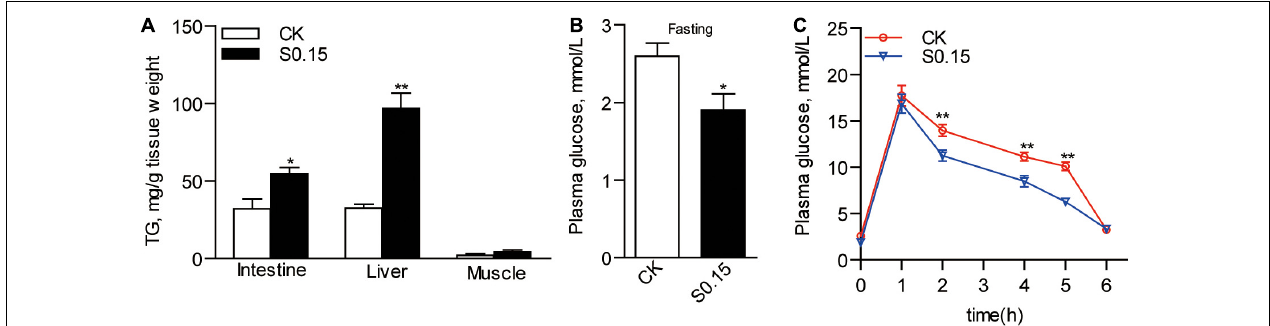
FIGURE 5 | Fat accumulation and glucose homeostasis in zebrafish fed the CK or S0.15 diet for 4 weeks. (A) Intestinal, hepatic, and muscular TG levels. (B) Fasting plasma glucose levels. (C) Glucose tolerance test. Values are means ± SEMs ( n = 4–21 biological replicates). * p < 0.05, ** p < 0.01. CK, control-check diet; S0.15, 0.15% succinate-supplemented diet.